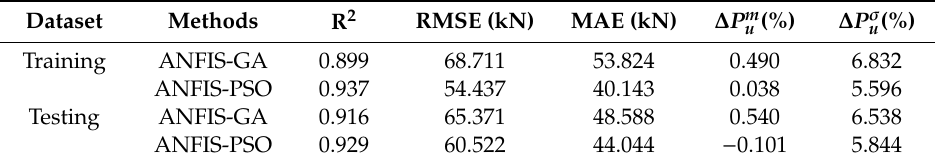
Figure 8. Graphs of ∆ P u in function of sample index for: ( a ) the training part; ( b ) the testing part. Table 3. Summary information of prediction capability ( ∆ P m u and Δ P (cid:3048)(cid:3097) are the average and standard deviation of ∆ P u , respectively).